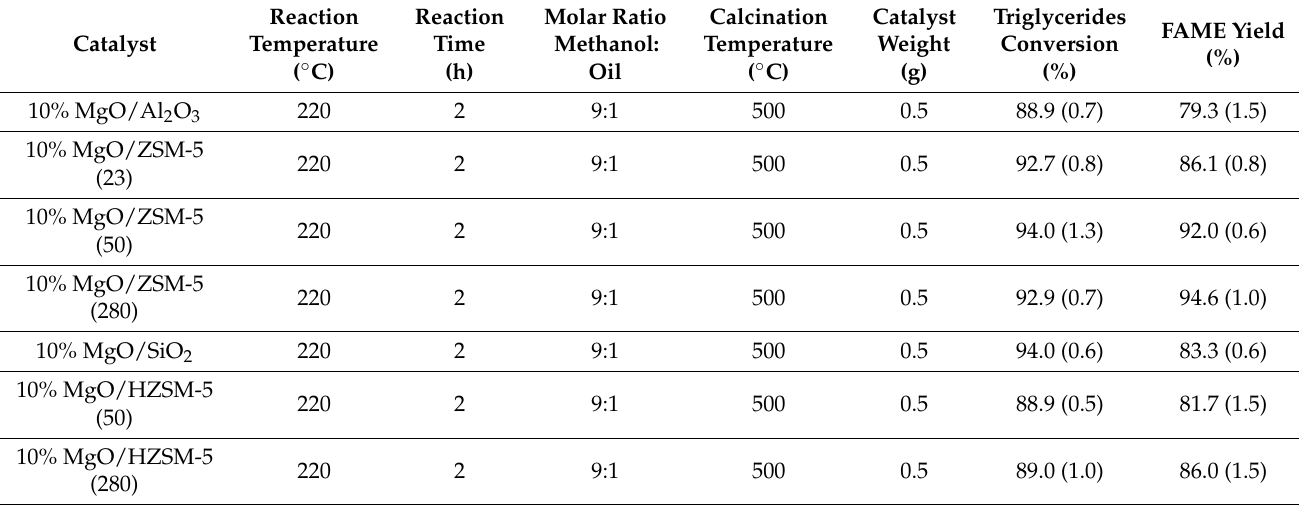
Table 1. The results of the transesterification process performed over various MgO catalysts, calcined systems. The ratio of silicon to aluminum is given in parentheses. Mean values and standard deviations (in parentheses) of triglyceride conversions and FAME yields are given in the